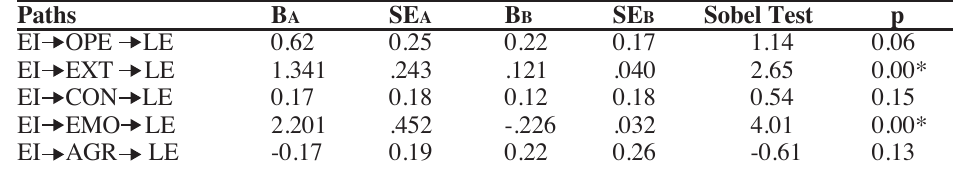
Table 3: Sobel Test Showing Mediation effect of Personality Traits for the relationship between Emotional Intelligence and Leadership